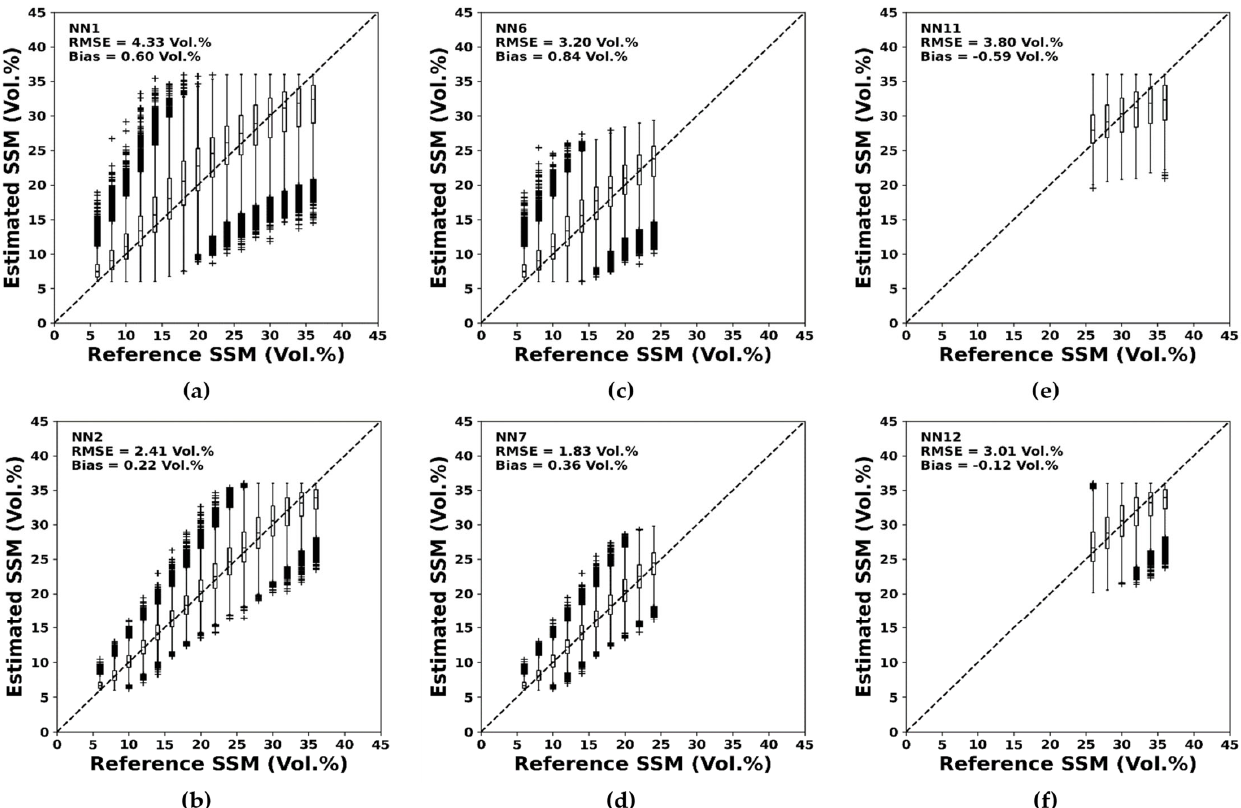
Figure 3. Estimated SSM as a function of the reference SSM using synthetic C-band data. ( a ) NN without using Hrms in input vector and no a priori information on SSM; ( b ) NN with reference Hrms (known without error) in input vector and no a priori information on SSM; ( c ) NN without using Hrms in input vector but using a priori information on SSM dry to slightly wet soil conditions; ( d ) NN with reference Hrms in input vector and a priori information on SSM dry to slightly wet soil conditions; ( e ) NN without using Hrms in input vector but using a priori information on SSM in very wet soil conditions; ( f ) NN with reference Hrms in input vector and a priori information on SSM in very wet soil conditions. The non ‐ filled boxes represent the distribution of the estimation results at each class with the median line of the scores and the plus signs represent the outliers of the estimations located outside the whiskers of the box plot.